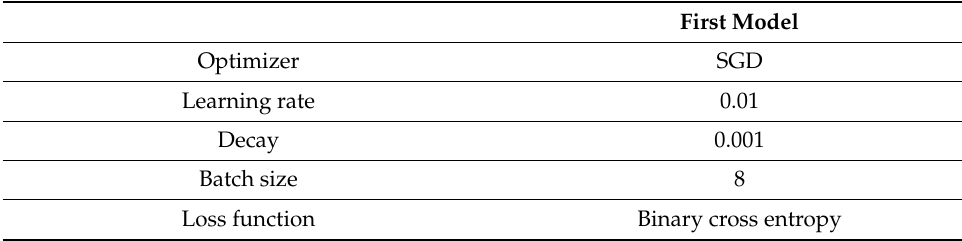
Table 2. Totally trained model’s characteristics.